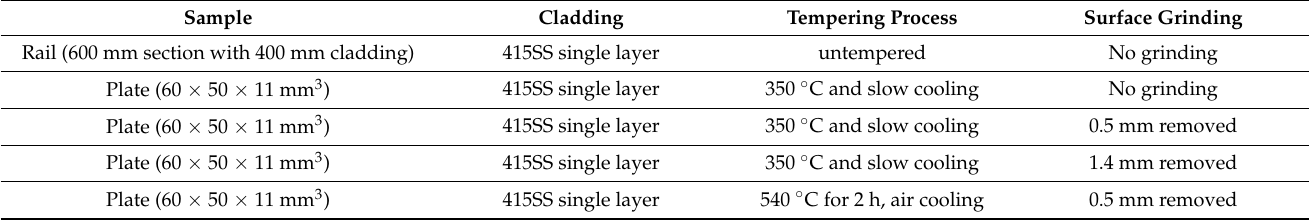
Figure 2. ( a ) The strain free reference sample. ( b ) Strain scanning locations in the transverse rail plane. Longitudinal scanning orientation of the ( c ) 415SS rail and ( d ) plates on the diffractometer stage. Table 2. Tempering and surface grinding conditions of the samples for residual stress measurement.